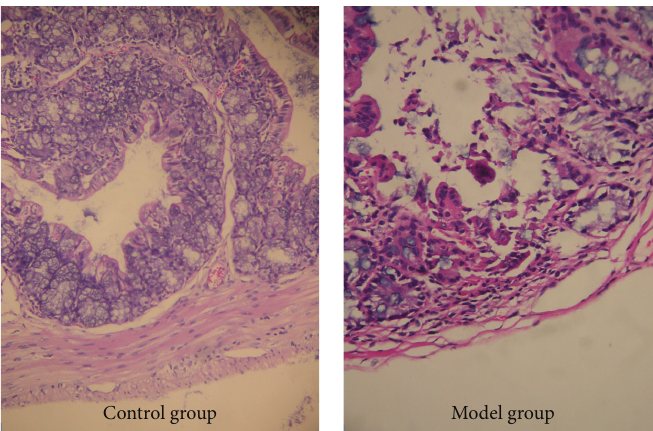
Figure 1: Pathological changes in the control group and UC model group on day 7 under light microscope (HE × 400). The colonic mucosa structure was intact in the control group. Mucosa and submucosa defects could be seen with infiltrations of inflammatory neutrophils and lymphocytes in the lamina propria in the UC model